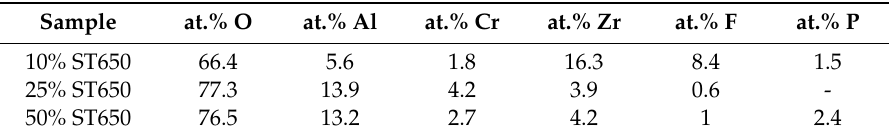
Table 5. The concentrations of elements obtained by XPS analysis for the AA3003 samples coated with ST650 conversion coatings of different concentrations: 10%, 25% and 50%. Sample at.% O at.% Al at.% Cr at.% Zr at.% F at.% P